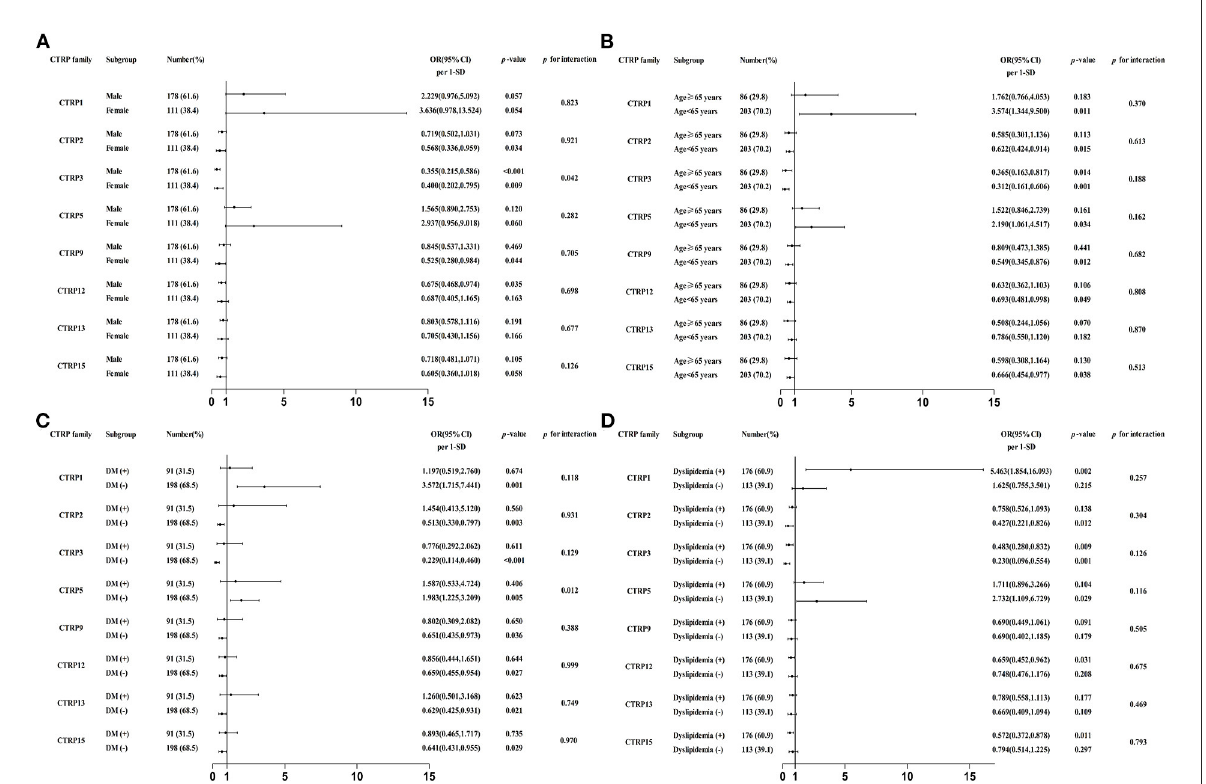
FIGURE3 Forest graphs based on subgroup analysis for the effect of CTRP family in patients with ACS. (A) Subgroup analysis according to sex of patients, adjusted for age, dyslipidemia, hypertension, and diabetes mellitus (DM). (B) Subgroup analysis according to age of patients, adjusted for smoking, dyslipidemia, hypertension, and DM. (C) Subgroup analysis according to DM status of patients, adjusted for sex, smoking, dyslipidemia, and hypertension. (D) Subgroup analysis according to dyslipidemia status of patients, adjusted for sex, smoking, hypertension, and DM.